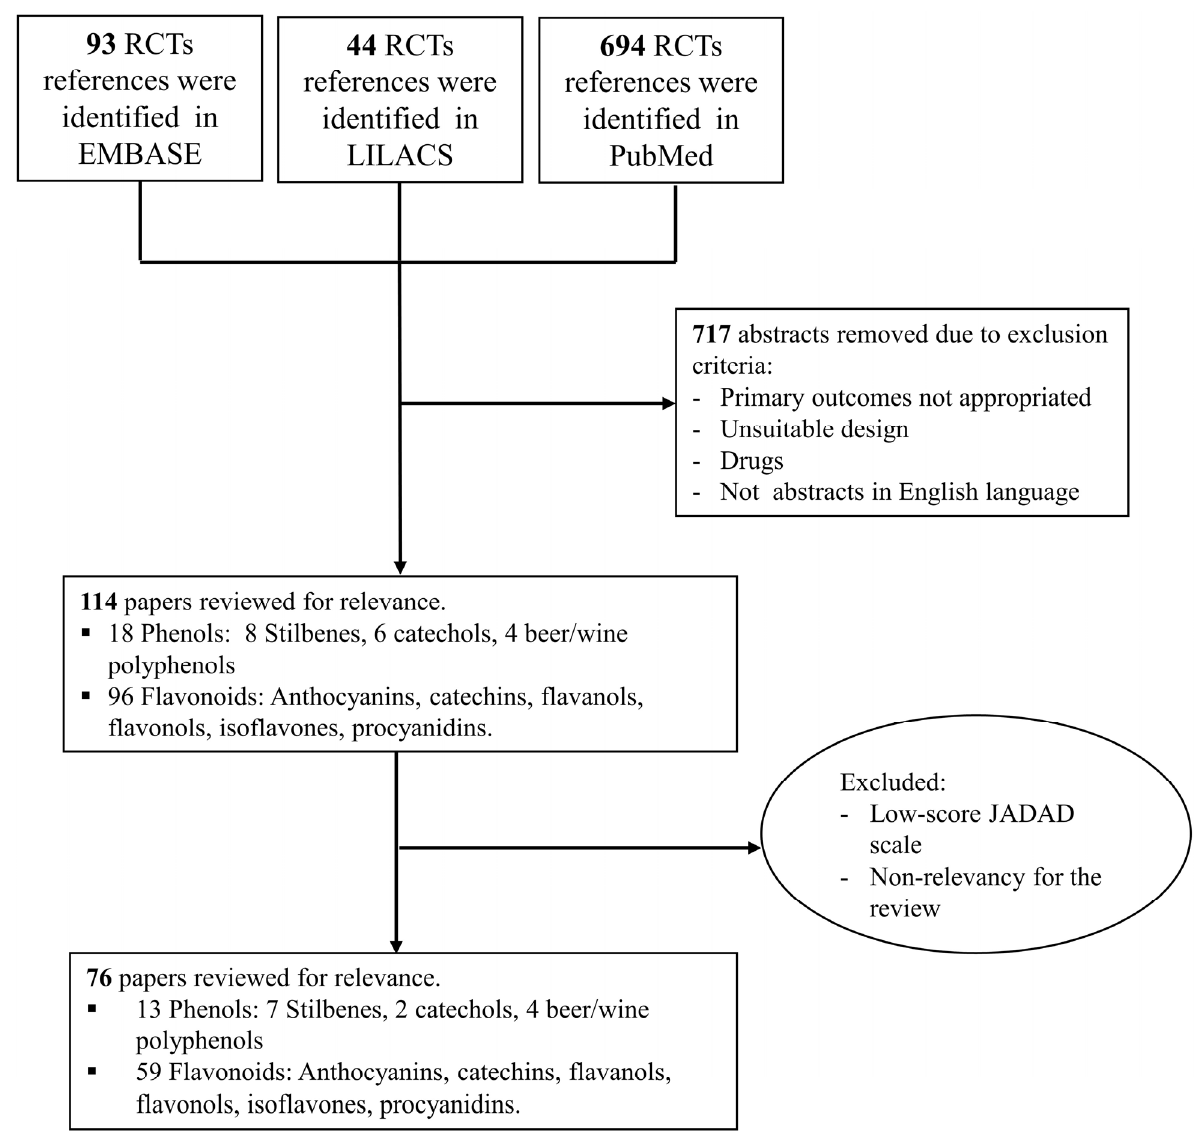
Figure 2. Review Flow